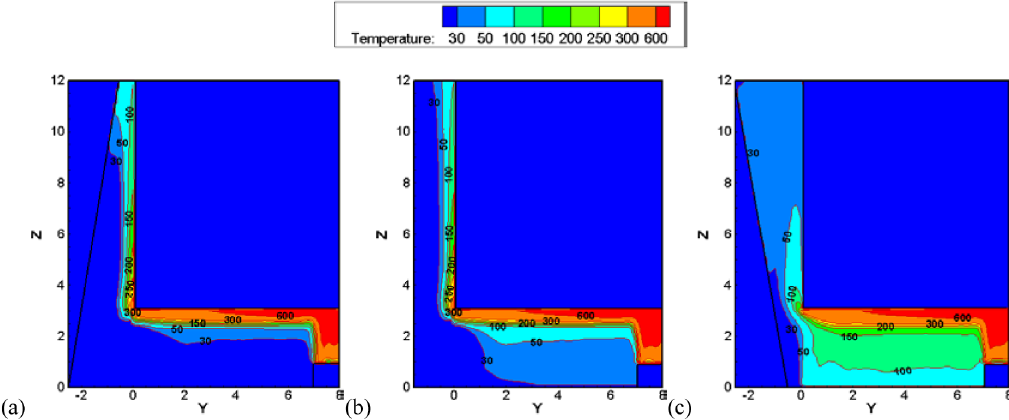
Fig. 11. Temperature distributionat the steady state with Q = 5MW when (a) θ = 80°, (b) θ = 90° and (c) θ = 100°